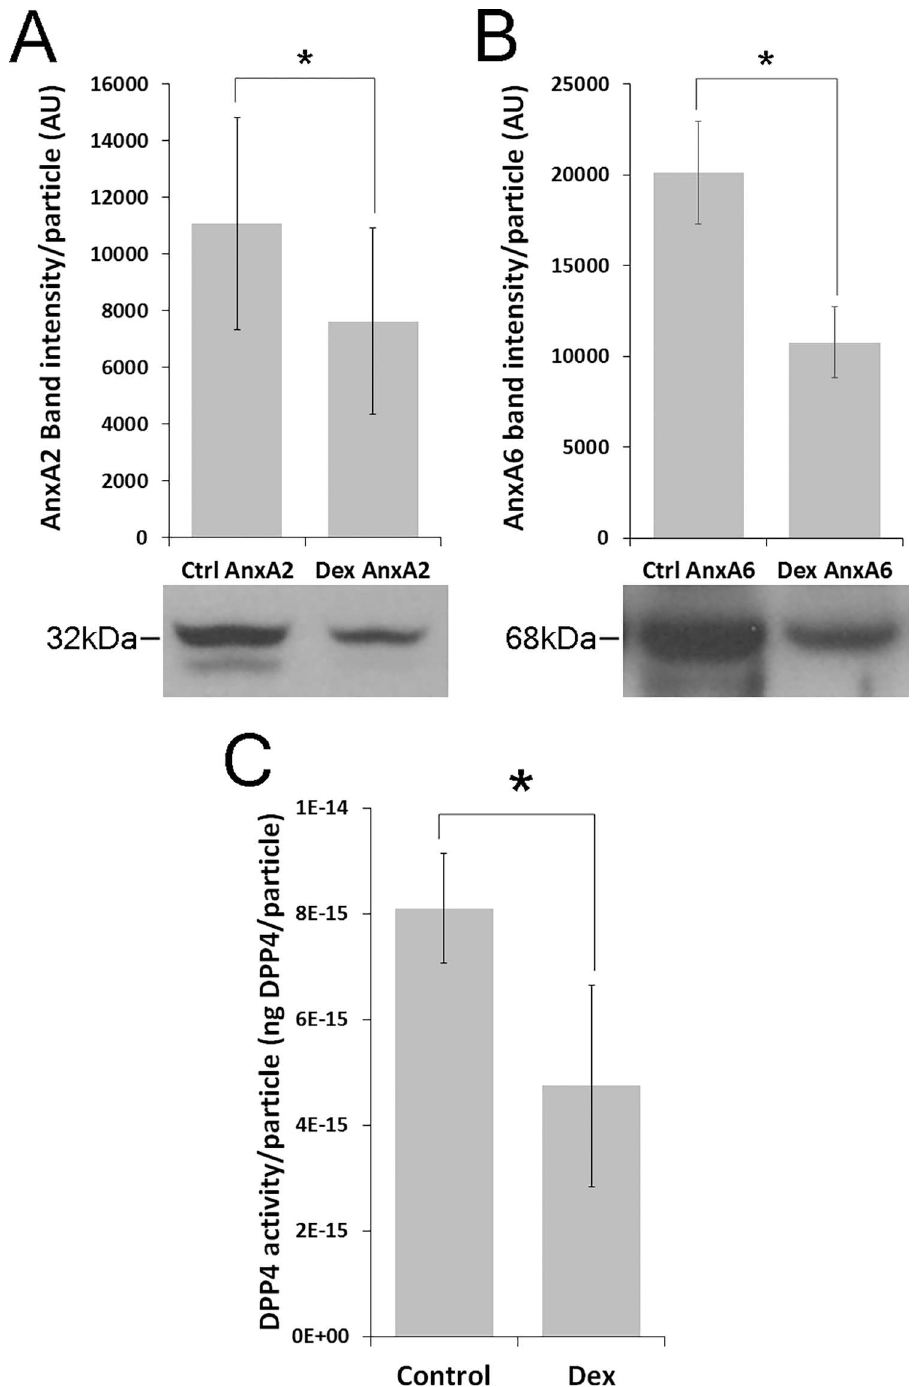
Fig 5. Treatment of human trabecular meshwork (TM) explants with dexamethasone decreasesthe amount of exosomal annexins A2/A6 and dipeptidyl peptidase activity. Exosomes were preparedfrom media conditioned by TM explants and analyzedfor the presence of the heparin/heparan sulfate binding proteins (A) annexin A2 and (B) annexin A6. Intensity of immunoblot staining was measured with ImageJ, normalized to the number of vesicles loadedper lane and shown in bar graphs as mean ± SEM. Panel A is representative of 4 biologicalreplicates (equal particle loadingper lane, 4 control, 4 Dex treated) and panel B is representative of 6 biologicalreplicates (6 control, 6 Dex treated). * p < 0.05 control vs Dex, Student’s t-test; annexinA2 n = 4, annexinA6 n = 6. C, Equal amounts of exosomes from control and Dex treated